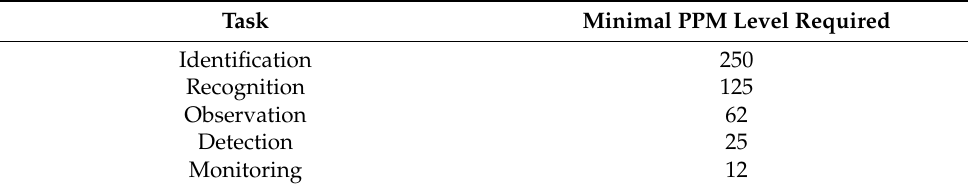
Table 2. Required PPM values for different tasks.